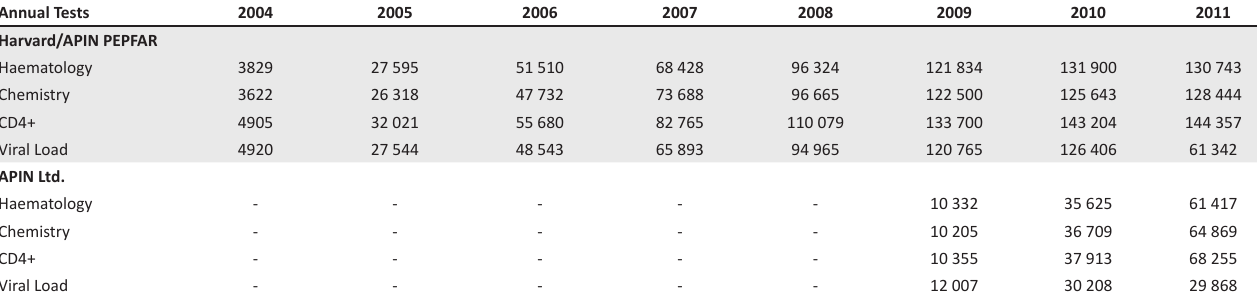
TABLE 2: Number of tests performed annually by Harvard/APIN PEPFAR